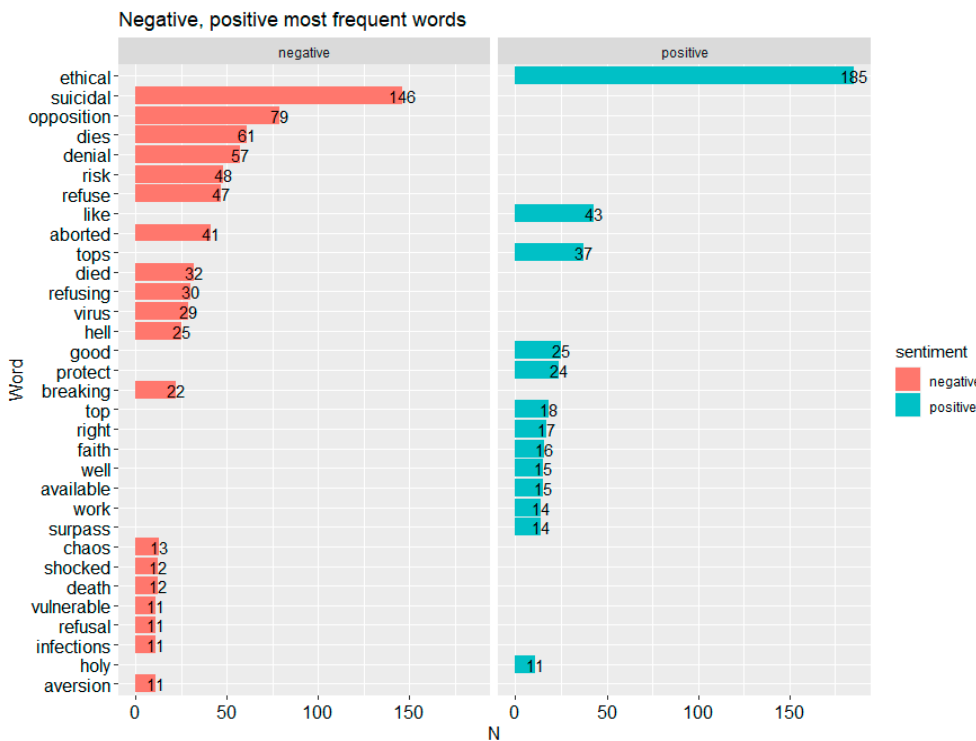
Figure 1. Most frequent words by type of sentiment. Made using the ggplot2 library in R (https://ggplot2.tidyverse.org/authors.html, accessed on 14 December 2021). The red bars represent sentiments found in tweets classified as negative using the tidytext library, while the blue bars represent positive tweets.